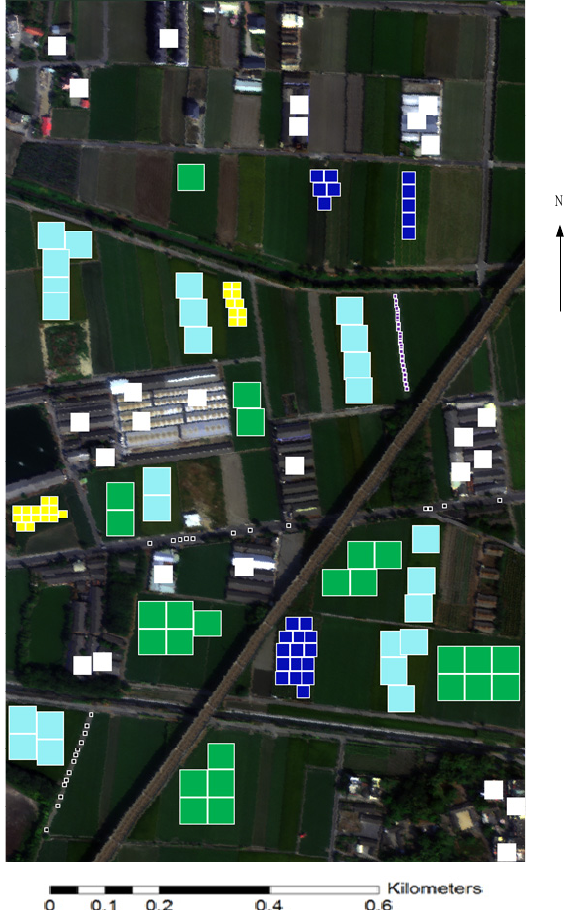
Figure 6. Resize window of CNN selection by the Cell program and the prepared inputs for CNN . Table 5 shows the confusion matrix of CNN by PCA selection of PCA1, PCA2, PCA3 to PCA8. The study decides to select the number of epochs which equals 30. It is found that only the potato fields have two misjudgments by omission error. The accuracy rate is 97.1%. Table 5. Confusion matrix of CNN by principle component analysis (PCA) 8 epoch 30.